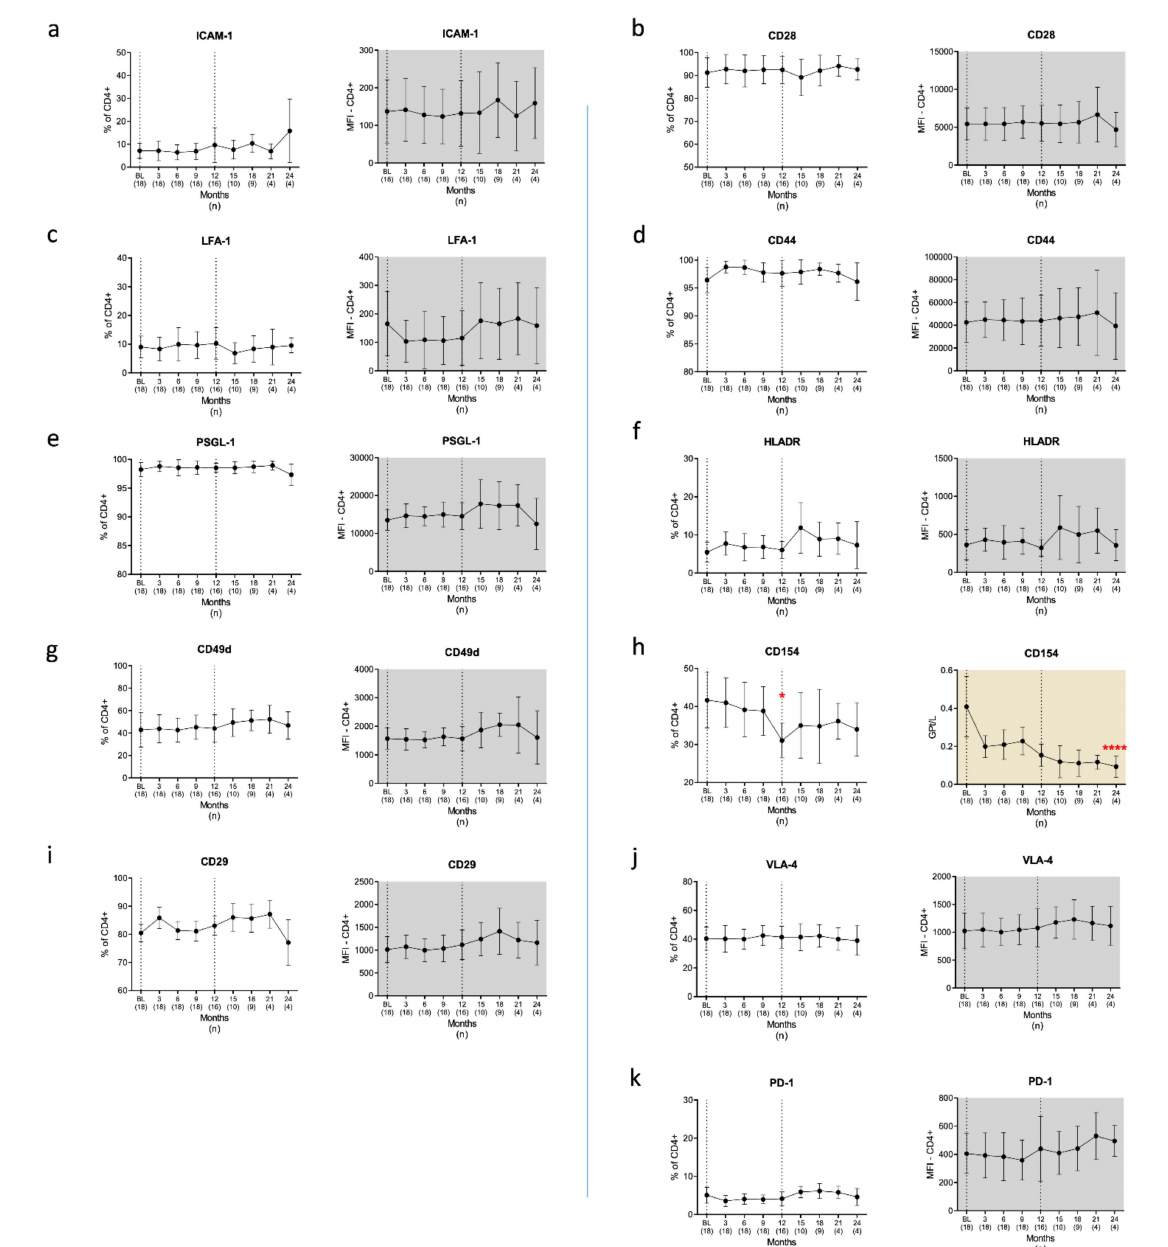
Figure 4. Adhesion and costimulatory surface proteins on the surface of T helper cells/CD4+ T lymphocytes ( a – k ). Blood was drawn before cladribine initiation (BL) and every 3 months over a period of 2 years and analysed by flow cytometry. CD154 expression decreased in relative as well as in absolute numbers ( h ). Legend: BL = baseline; n = number of patients included at each time point. Data are shown as mean values ± SD. * p ≤ 0.05 and **** p ≤